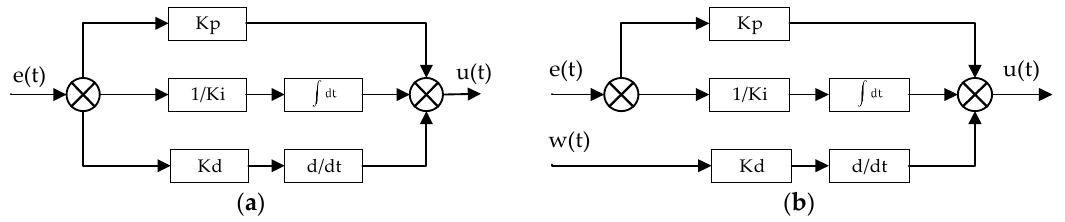
Figure 9. Comparison of basic PID regulator types. ( a ) — the classic approach with single error input, ( b ) — regulator with derivative gain input connected directly to sensor measurements (used in the project), where e(t) — input error, w(t) — sensor measurement, u(t) — regulator output.